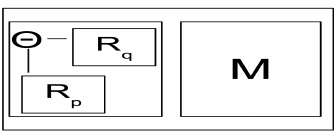
Figure 4. A context-aware action system for the extended